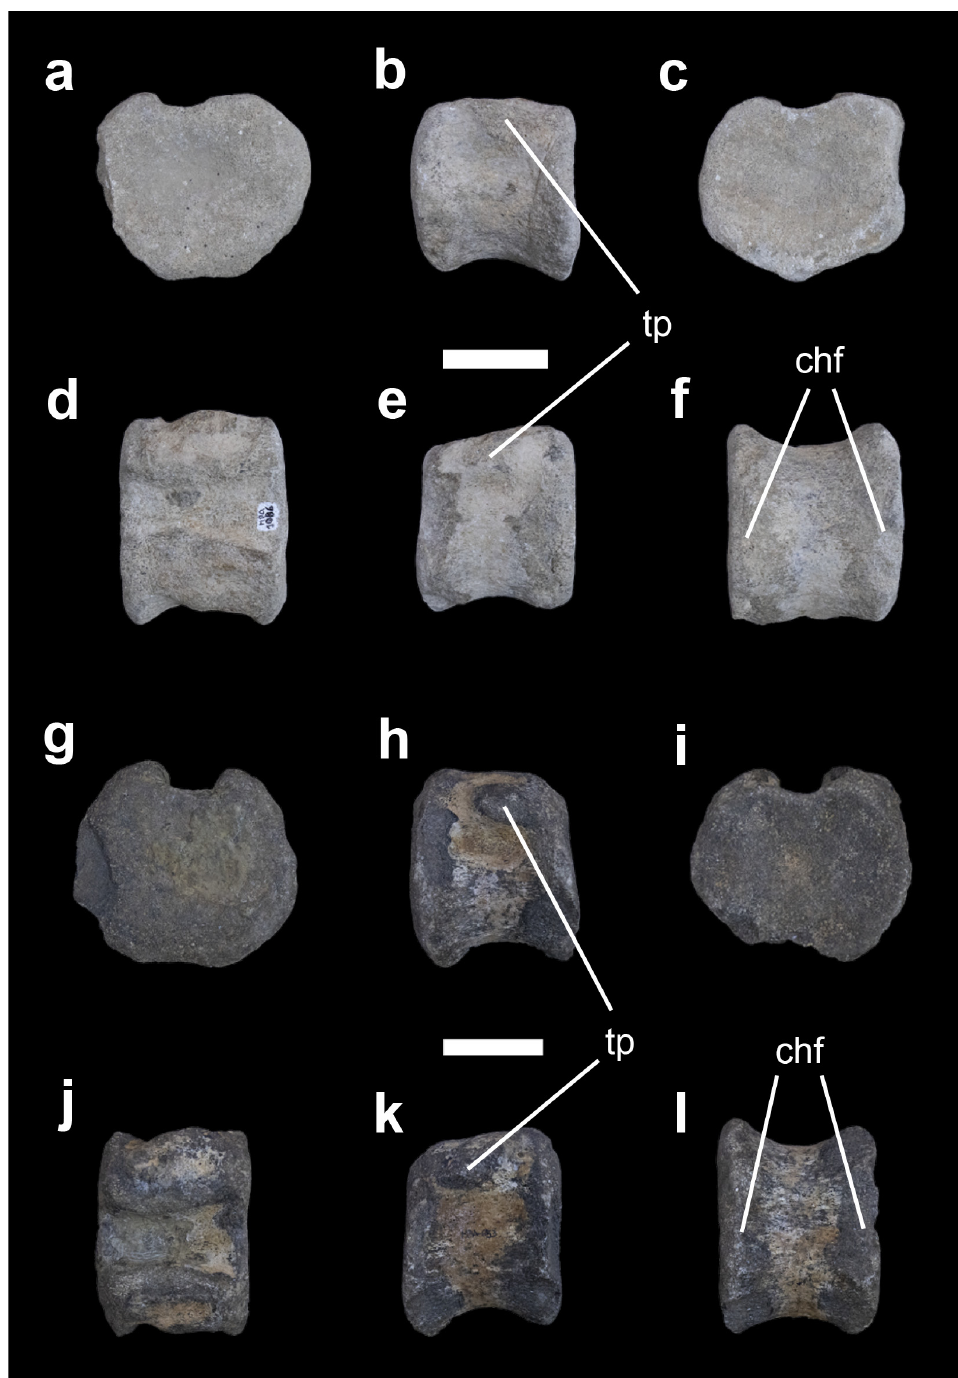
Figure 5. Vertebral centra from unknown fossil sites (Alpuente, Valencia, Spain). Middle caudal centrum (MPA-1086) in anterior ( a ), left lateral ( b ), posterior ( c ), dorsal ( d ), right lateral ( e ) and ventral ( f ) views. Middle caudal centrum (MPA-653) in anterior ( g ), left lateral ( h , k ), posterior ( i ), dorsal ( j ), right lateral ( k ) and ventral ( l ) views. Abbreviations: chf: chevron facet; tp: tranverse process. Scale bar = 5 cm.